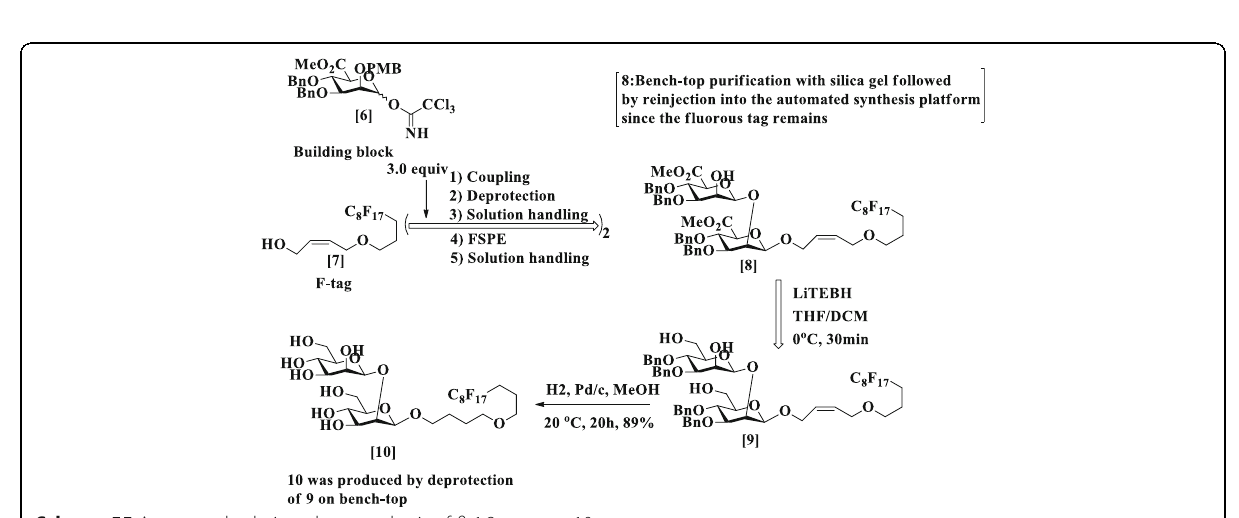
Scheme 55 Automated solution-phase synthesis of β -1,2-mannan